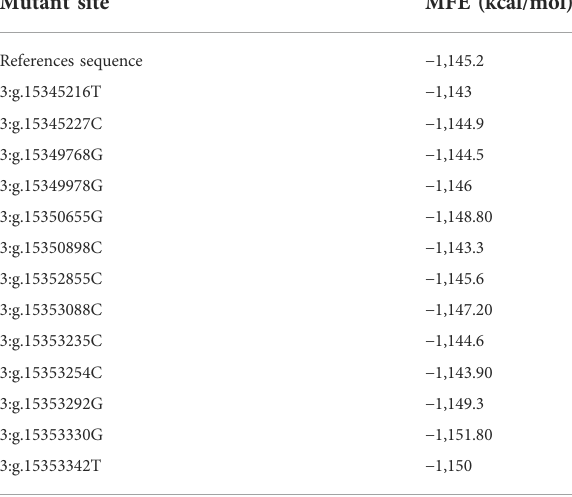
TABLE 4 The minimum free energy (MFE) values of optimal secondary structure of PKLR